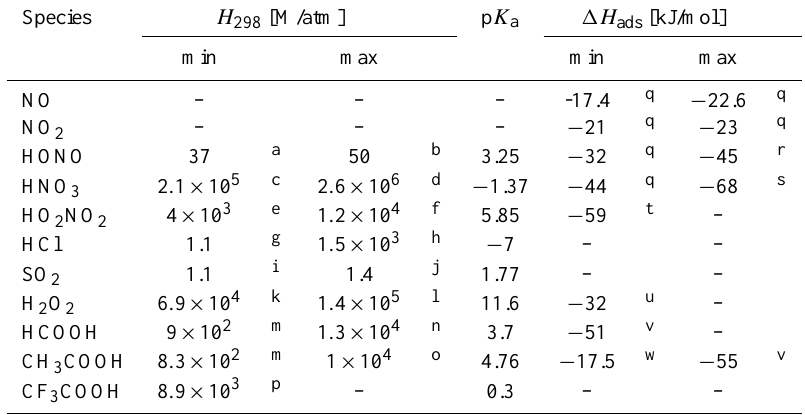
Table 1. Solubility, acidity (p K a ) , and adsorption enthalpies (DHads). The solubility is given as molecular Henry constant at 298K ( H 298 ) . Species H 298 [M/atm] p K a 1H ads [kJ/mol] min max min max NO – – – -17.4 NO